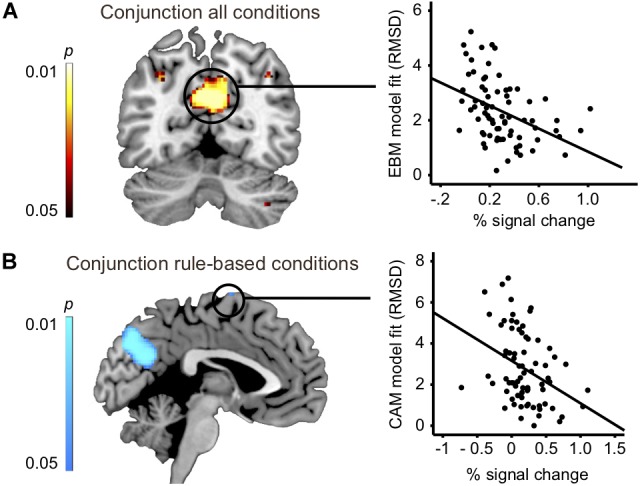
(A) Left panel: conjunction analysis: all four conditions vs. baseline (slice at MNI coordinate y = –60). Right panel: Correlation analysis: Brain activity difference between task and baseline in precuneus (Table 5) significantly correlated with model fit of the exemplar-based model (RMSD: r = –0.42; p < 0.001; n = 74). (B) Left panel: Conjunction analysis: instructed and spontaneous rule-based conditions vs. baseline (slice at MNI coordinate x = –2). Correlation analysis: Brain activity difference between task and baseline in superior frontal gyrus (BA6, Table 5) significantly correlated with model fit of the cue-abstraction model (RMSD: r = –0.36; p = 0.002; n = 74).